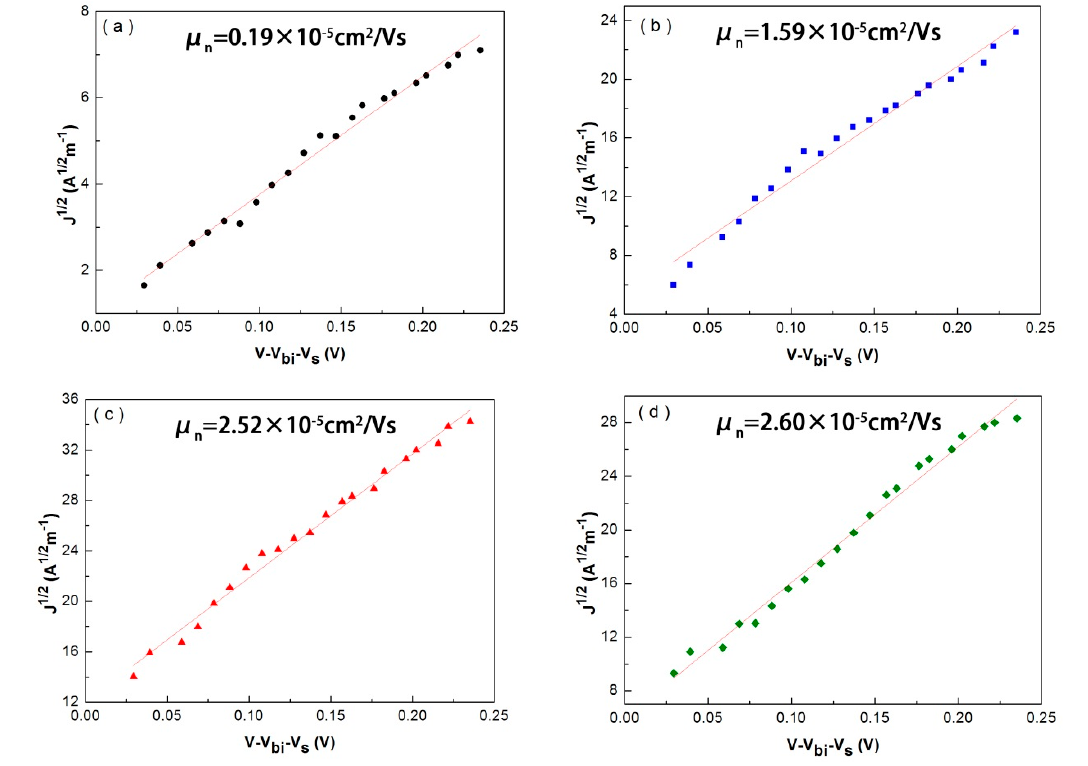
Figure 5. SCLC measurements of TiO 2 thin films with dopant concentration a 0% Sb-doped ( a ); 1% Sb-doped ( b ); 3% Sb-doped ( c ); and 5% Sb-doped ( d ).